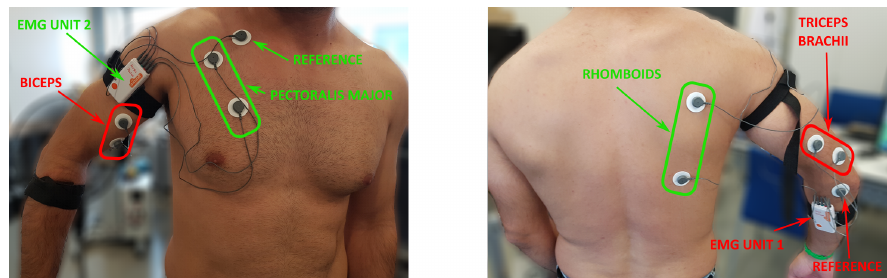
Figure 7. Disposition of the electrodes used to obtain the EMG signal in upper-arm and torso. The participant that appears in the figure has provided written and informed consent for its publication.